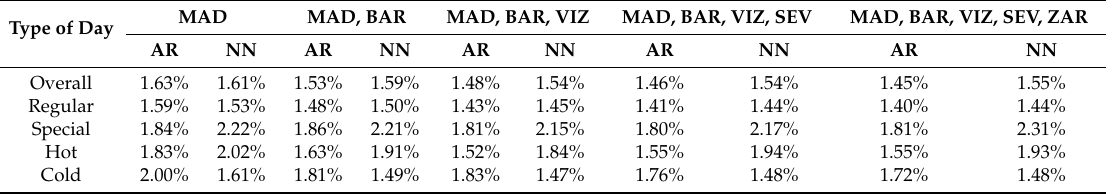
Table 3. Forecasting error (RMSE) with available temperature location from 1 to 5.